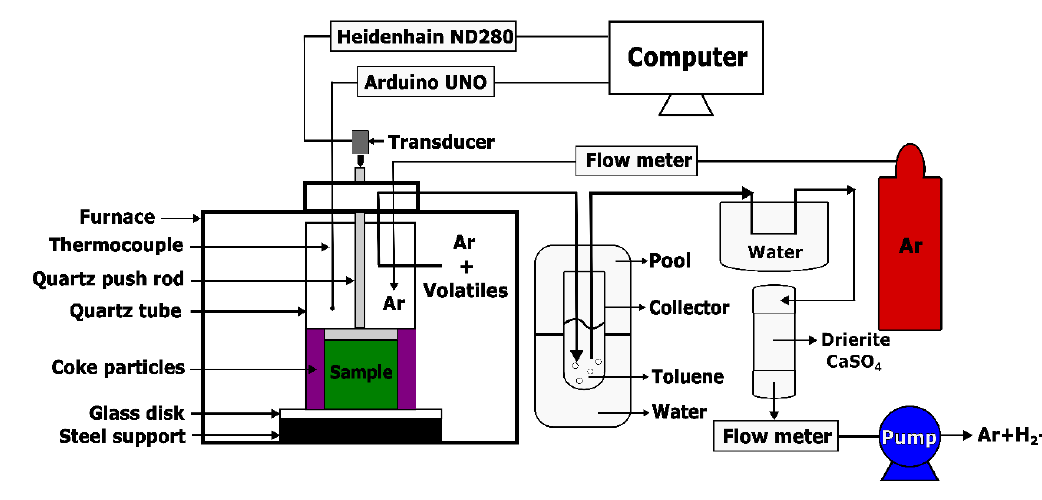
Figure 4. Schematic representation of dilatometry set-up.